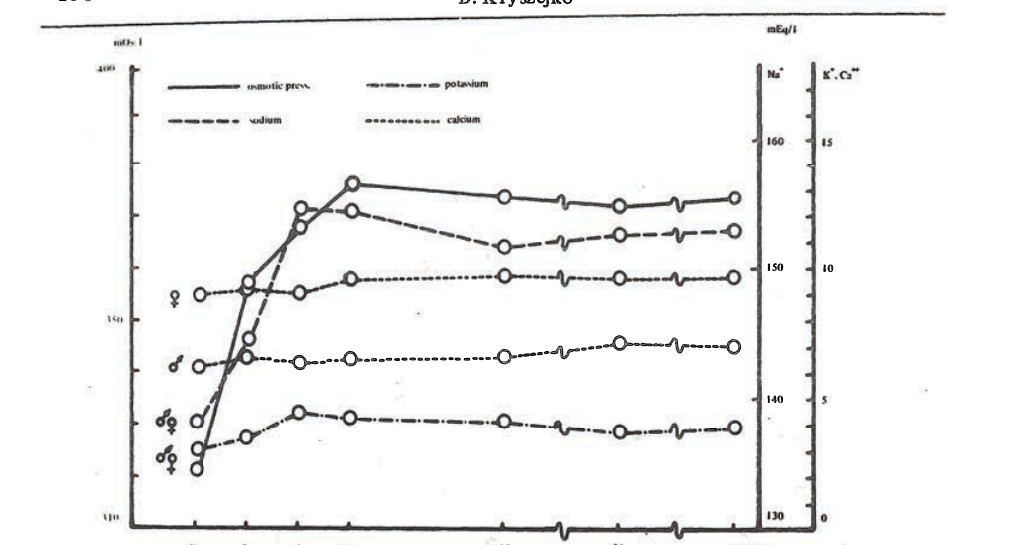
Fig. 3. Ionic-osmotic changes in pike blood serum at salinity of 12 par thousand (spring 1969, 1970) m0,/1 400 --- ounolicpre!lll.